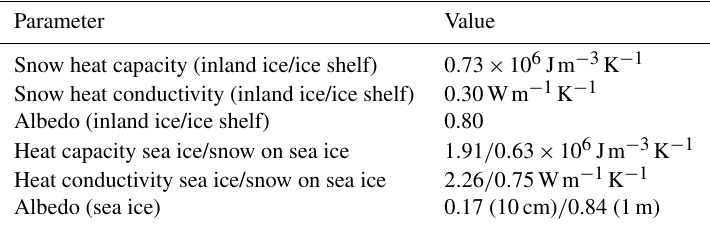
Table 2. Overview of surface parameters.